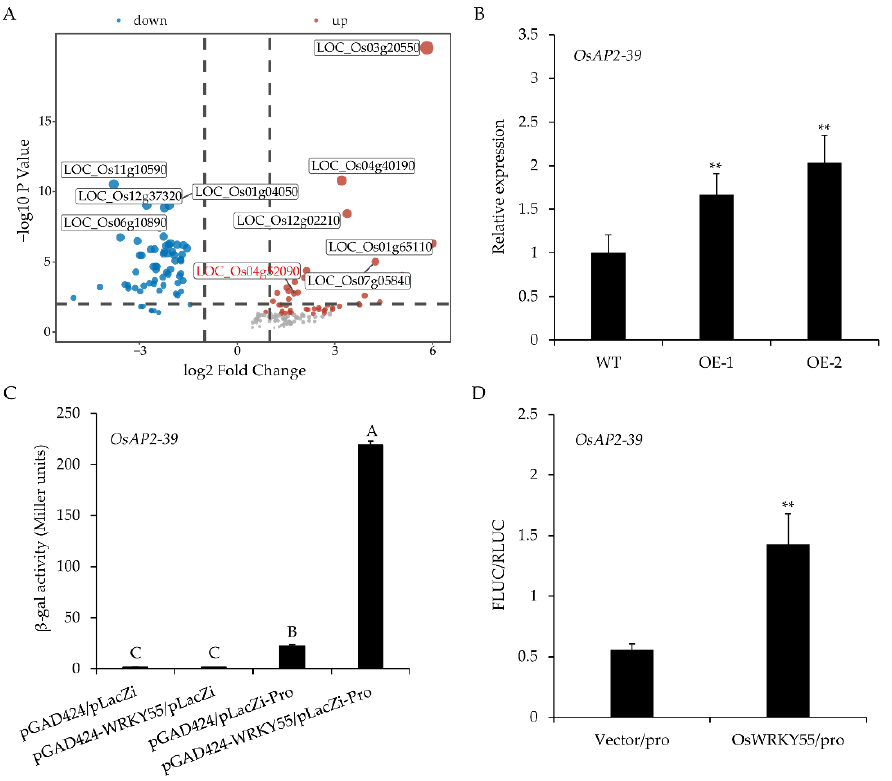
Figure 6. OsWRKY55 positively regulates the expression of OsAP2-39 . ( A ) Identification of differentially expressed genes (DEGs) in transgenic lines overexpressing OsWRKY55 compared to the wild type (WT) under normal conditions via RNA-sequencing (RNA-seq) analysis. The blue and red spots represent down-regulated and up-regulated genes, respectively. The sizes of the spots indicate the -log 10 FDR. ( B ) Relative expression of the OsAP2-39 gene in WT plants and transgenic lines overexpressing OsWRKY55 (OE-1 and OE-2). The rice OsActin gene was used as the internal control. Values shown are means ± SD (n = 3), ** p < 0.01 (Student’s t -test). ( C ) β -galactosidase activity levels in co-transformed yeast cells. Values shown are means ± SD (n = 3). Different uppercase letters above the bars indicate significant differences (least significant differences, p < 0.01). ( D ) Transcriptional activity of OsAP2-39 in rice protoplasts harboring the effector vector pAN580-OsWRKY55 compared to that in protoplasts carrying the empty vector. The transient expression of FLUC driven by the promoter of OsAP2-39 was normalized to the internal control reporter (RLUC). Values shown are means ± SD (n = 3), ** p < 0.01 (Student’s t -test).